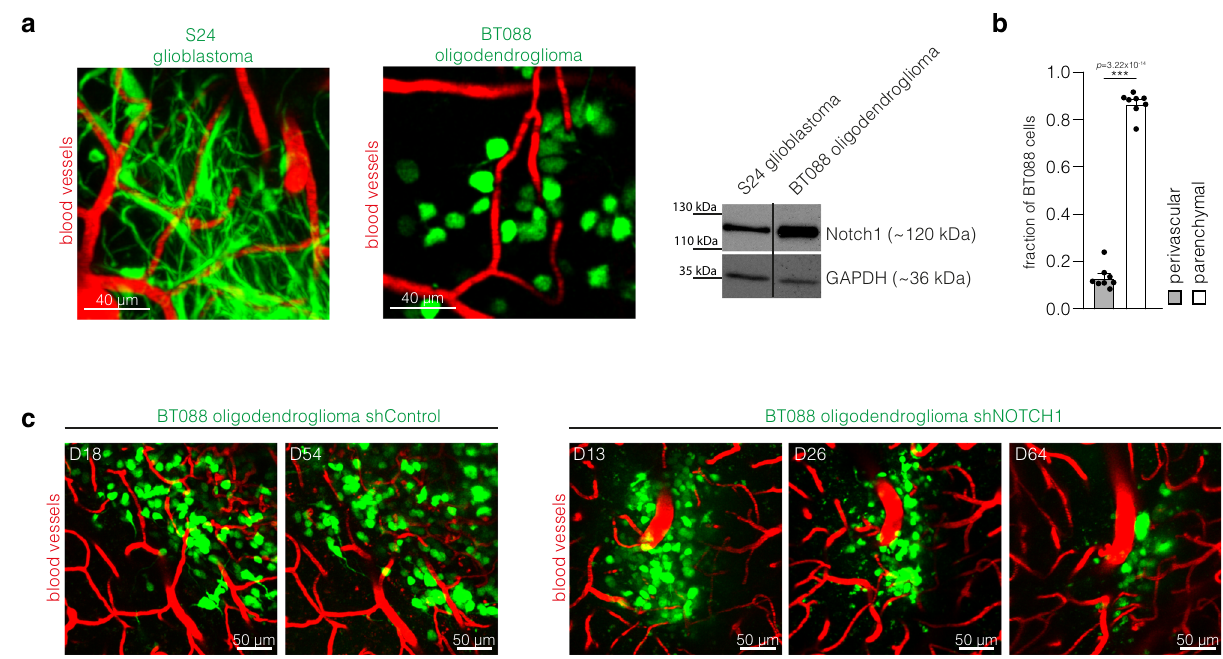
Fig. 7 NOTCH1 pathway activation in TM-de fi cient oligodendrogliomas. a Left: Exemplary intravital 2-PM images of S24 glioblastoma and BT088 oligodendroglioma cells (D21 after tumor implantation). Right: Western blot analysis of the Notch1 expression in S24 glioblastoma stem-like cells (GBMSCs) and BT088 oligodendroglioma cells. Loading control: GAPDH. b Quanti fi cation of the distribution of BT088 oligodendroglioma cells in the perivascular and parenchymal compartment ( n = 8 regions in 5 mice, D21 ± 3, two-tailed t -test). c Exemplary images of BT088 shControl oligodendroglioma cells and BT088 shNOTCH1 cells demonstrate tumor regression after NOTCH1 knockdown. Data b are represented as mean + SEM. *** p < 0.001.